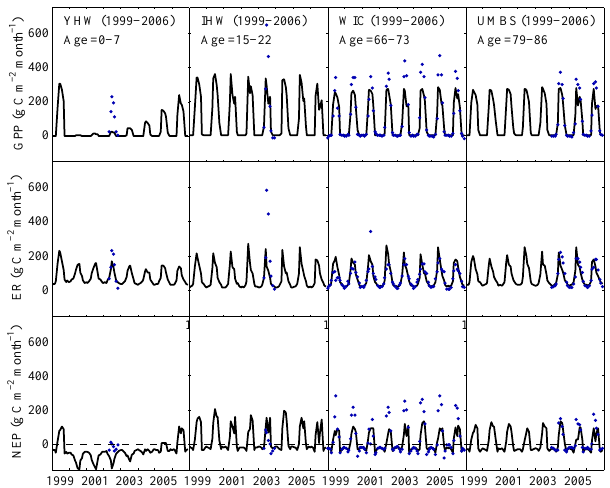
Figure 2. Simulated (lines) and observed (symbols) monthly carbon fluxes: GPP, ER, and NEP for the evergreen needleleaf chronose- quence study sites from 2002 to